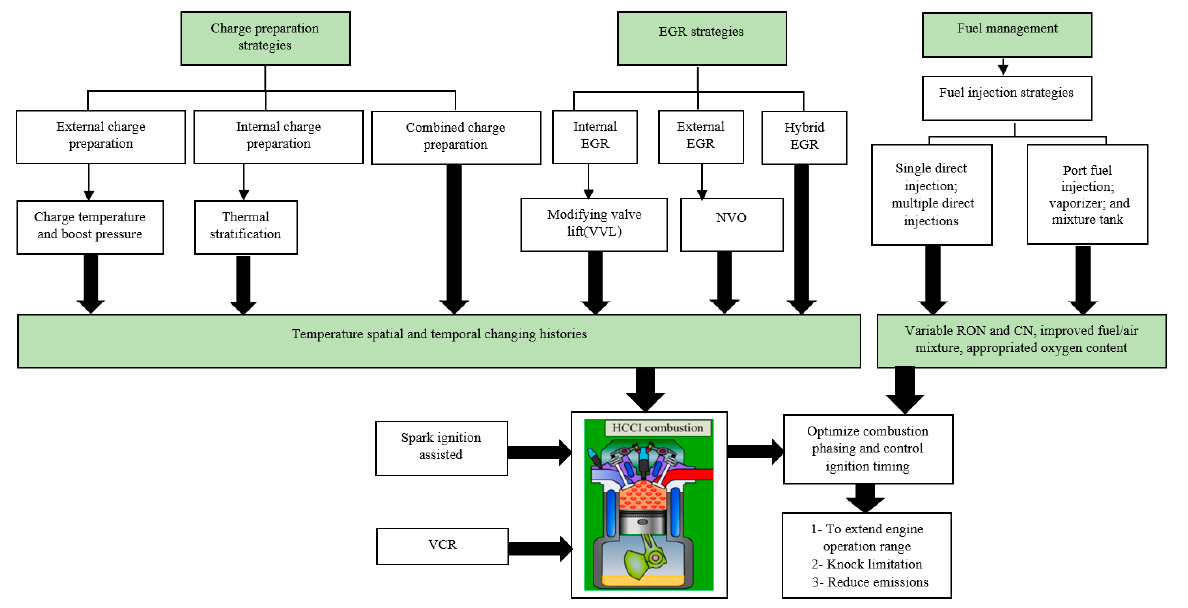
Figure 10. Schematic diagram of effective techniques used to control combustion phasing and ignition timing of HCCI engines [135,163].